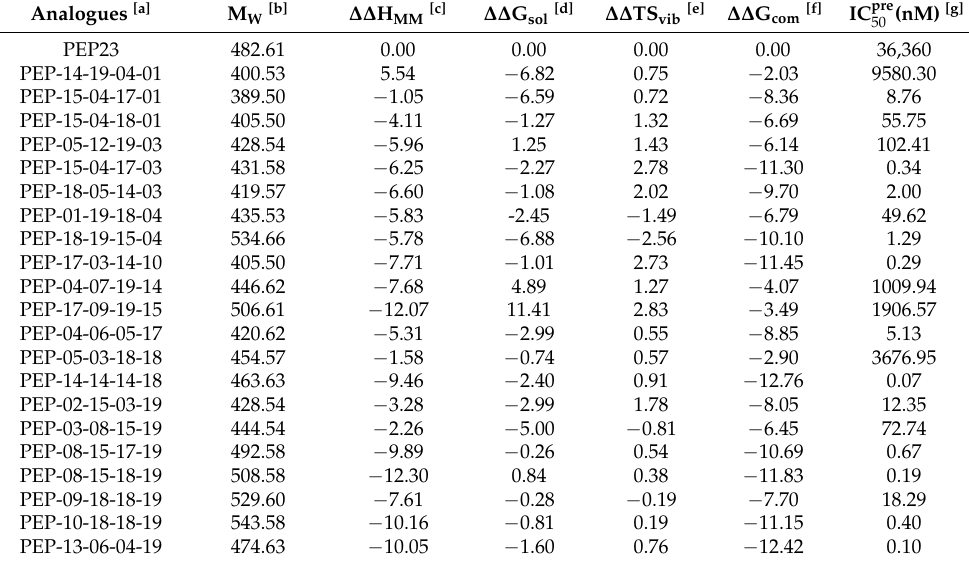
Table 7. Complexation Gibbs free energy and its components for the top 21 scoring virtually designed analogues. The analogue numbering concatenates the index of each substituent R1 to R4 numbered in Table